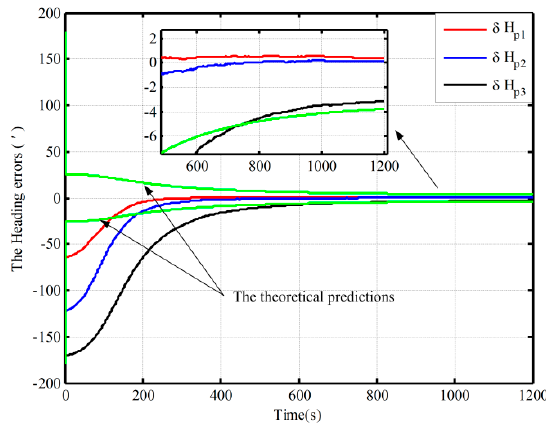
Figure 13. The polar closed-loop KF alignment at 85° latitude.